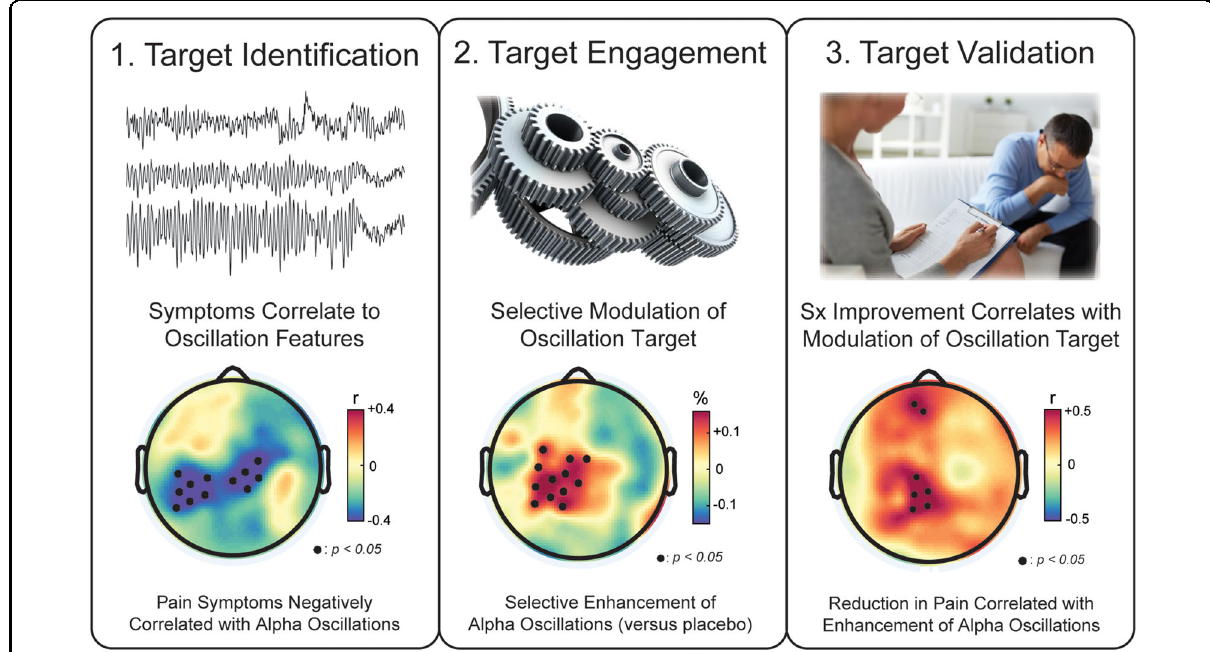
Fig. 2 Rational design of clinical trials using tACS. Top: rational of a tACS intervention comprises 1 target identi fi cation (based on known correlations between EEG oscillation features and symptoms), 2 target engagement (demonstration of successful modulation of oscillatory network target), and 3 target validation (demonstration of clinical improvements correlating with change in oscillations by tACS). Bottom: results from a tACS study of target engagement and symptom modulation in patients with chronic low-back pain. In this case, the network oscillation target was pathologically reduced alpha oscillations (top-down inhibition) in the somatosensory-motor cortical pain network 60